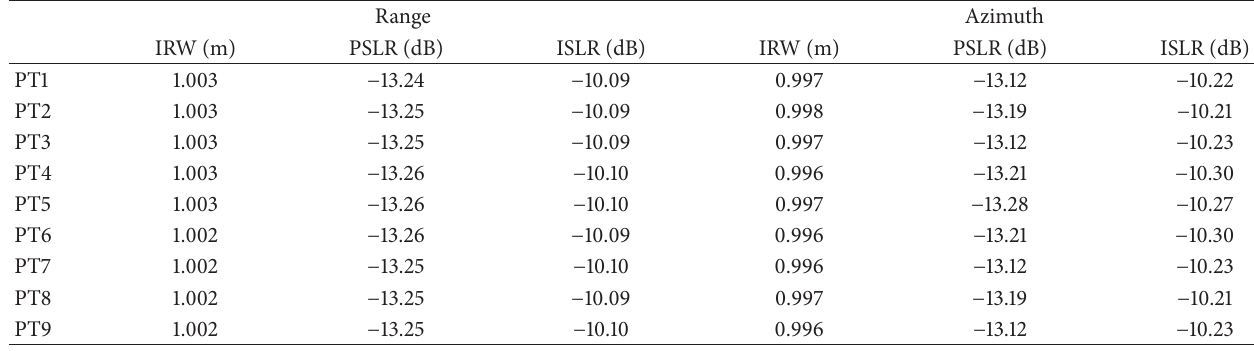
Table 2: Performance analysis of point targets.